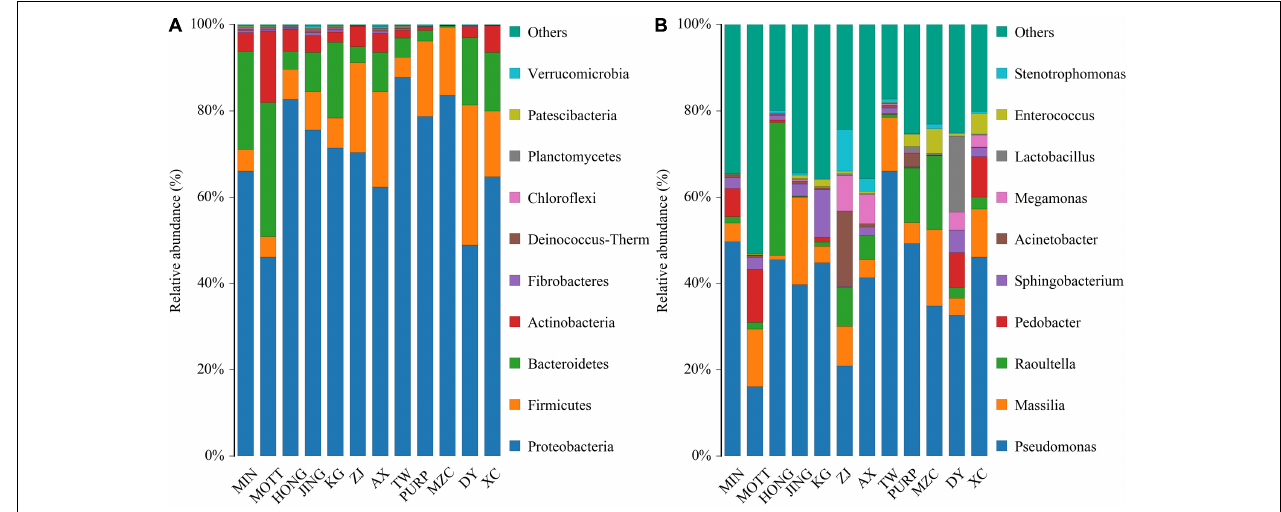
FIGURE 1 | Relative abundance of bacterial composition in P. sinese silages at phylum (A) and genus (B) level.